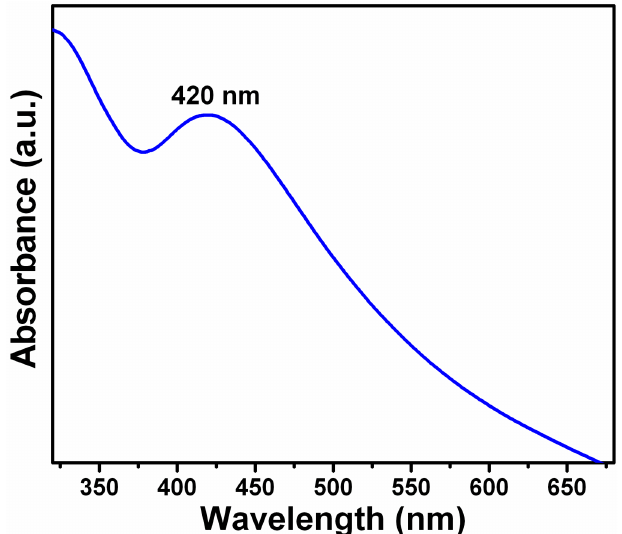
Figure 1. UV-Vis absorption spectrum of silver nanoparticles.